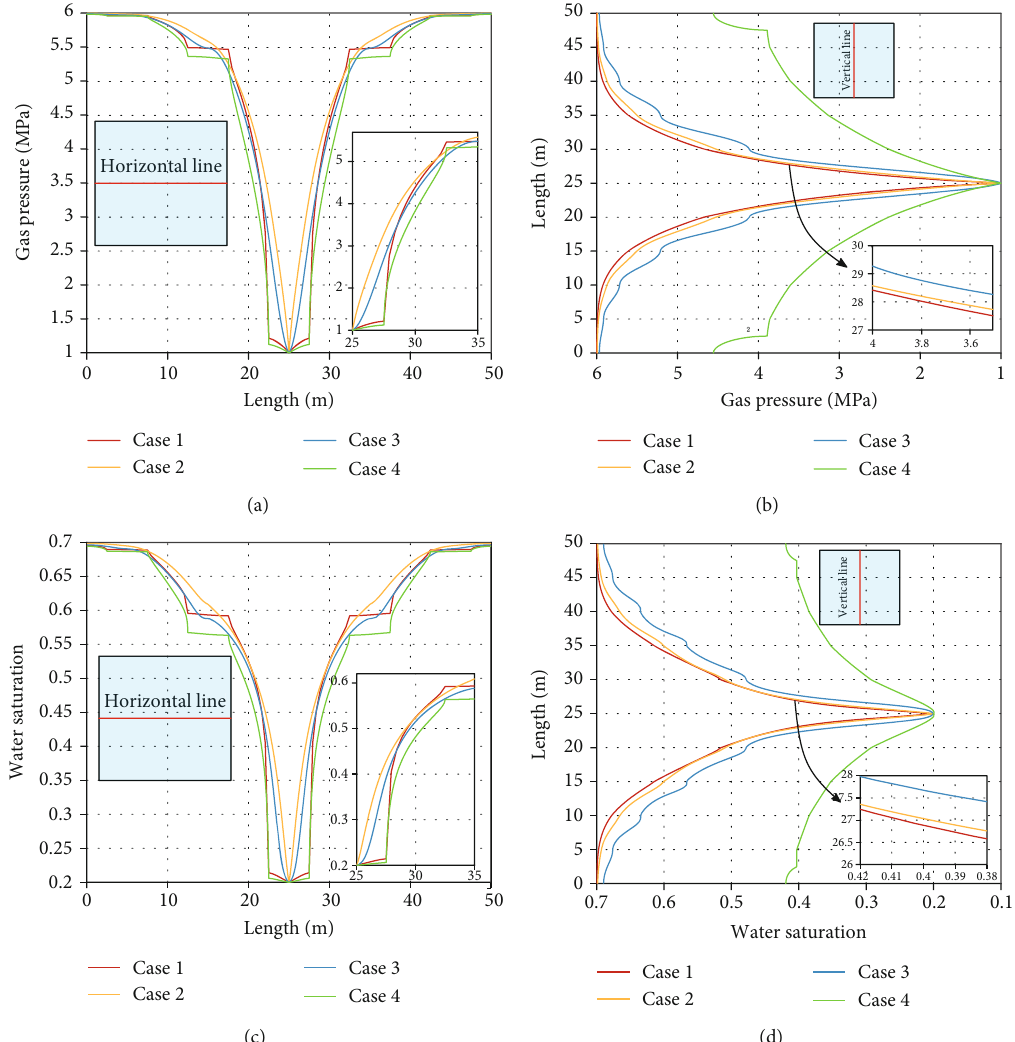
Figure 9: (a, b) Gas pressure and (c, d) water saturation along the horizontal and vertical lines, respectively, after 250 days of production in the four